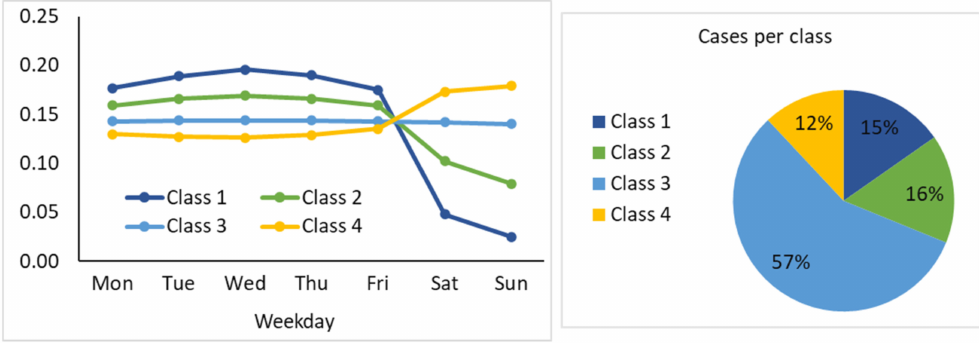
Figure 15. Four prototypes for week patterns defined by a range of 39,126 available